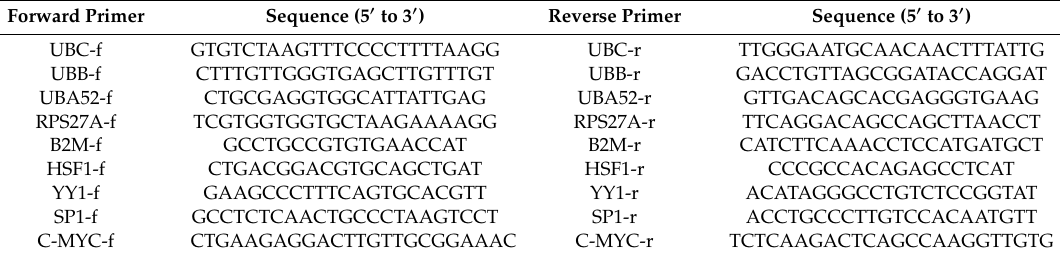
Table 1. Oligonucleotides used for quantitative real-time